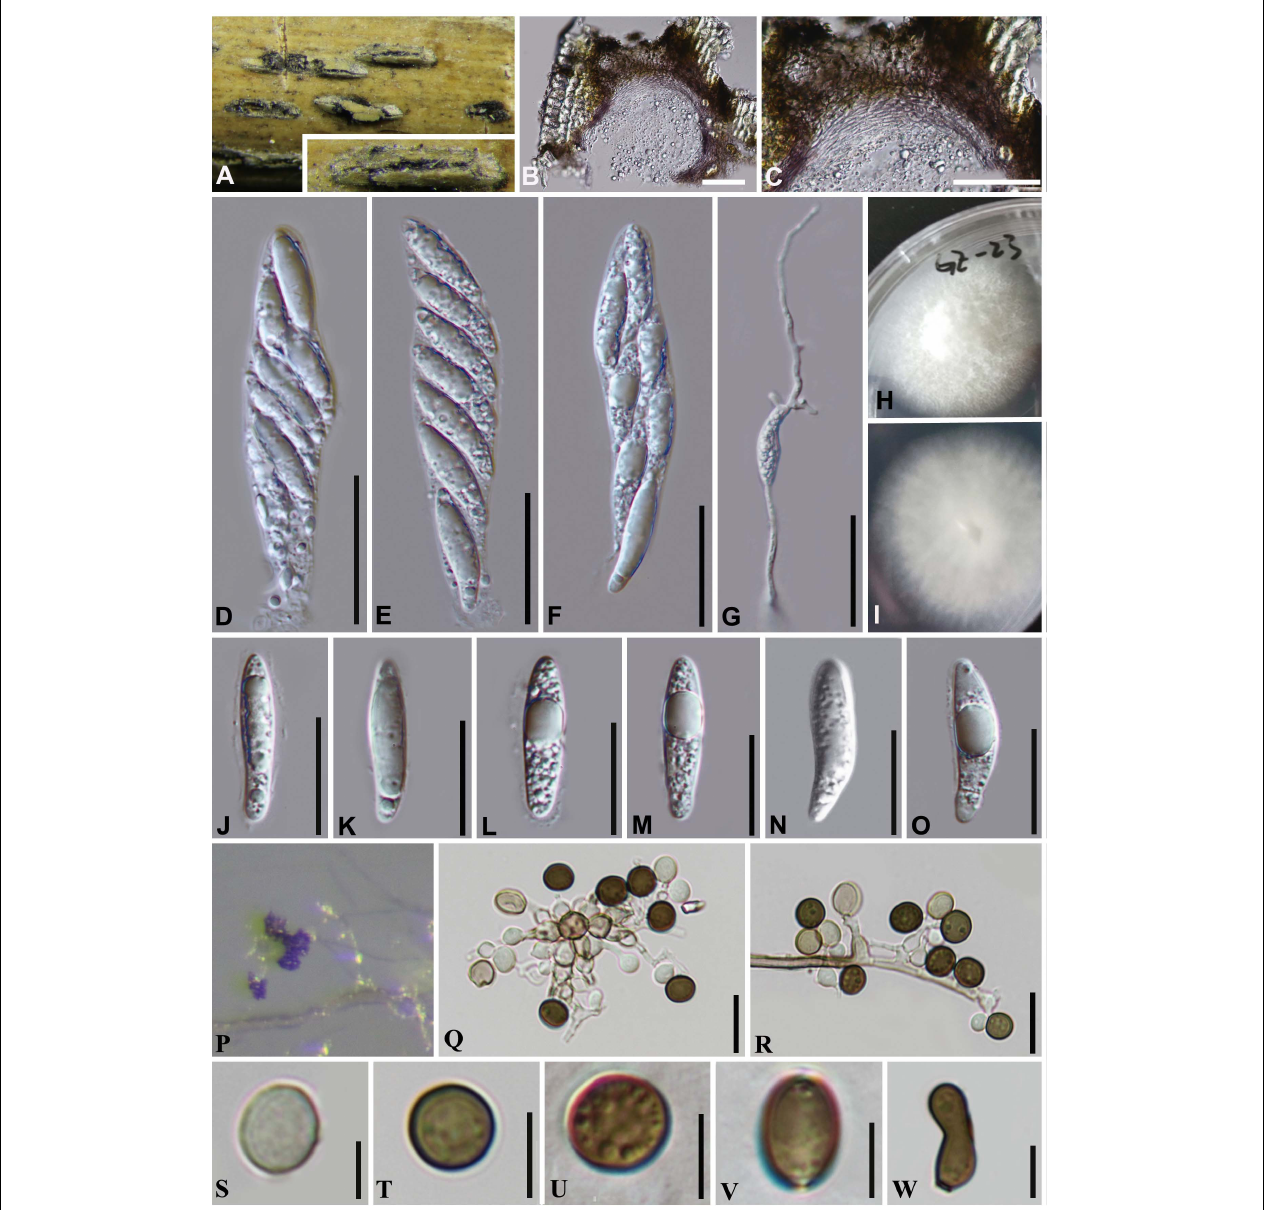
FIGURE 7 | Arthrinium guizhouense (GZAAS 20–0114). (A) Appearance of stromata on bamboo host. (B) Vertical section of stroma. (C) Peridium. (D–F) Asci. (G) Germinating ascospore. (H,I) Culture. (J–O) Ascospore. (P) Colony on WA producing conidia masses. (Q,R) Conidiogenous cells giving rise to conidia. (S–V) Conidia. (W) Sterile cell. Scale bars: (B,C) = 50 µ m. (D–F) = 30 µ m. (G) = 50 µ m. (J–O) = 20 µ m. (Q,R) = 10 µ m. (S–W) = 5 µ m.